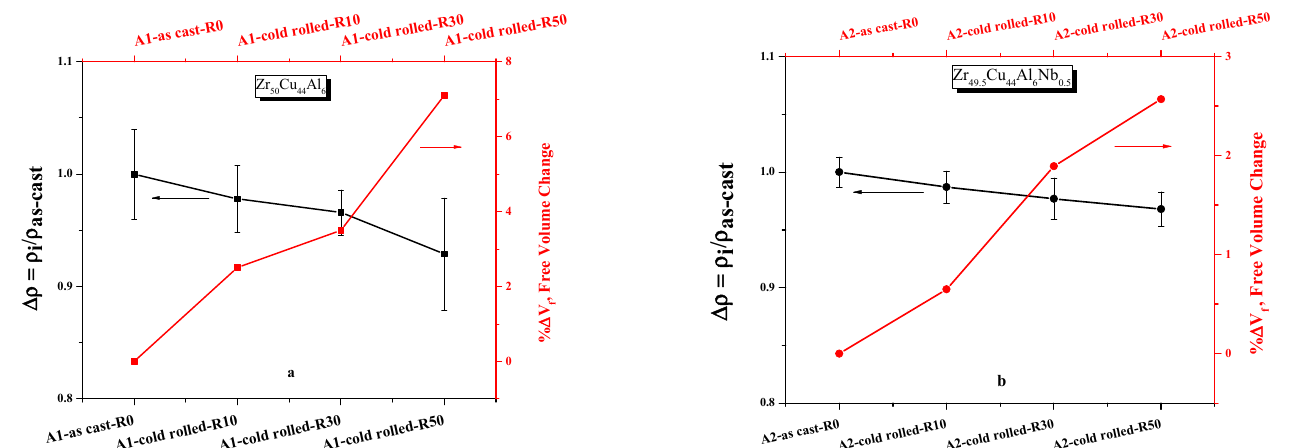
Figure 4. Archimedes density and free volume change induced by cold rolling of ( a ) A1 and ( b ) A2 ribbons as a function of plastic strain (R0–R50). Using the black lines to present the trend of density and the red lines to present the trend of FV change.